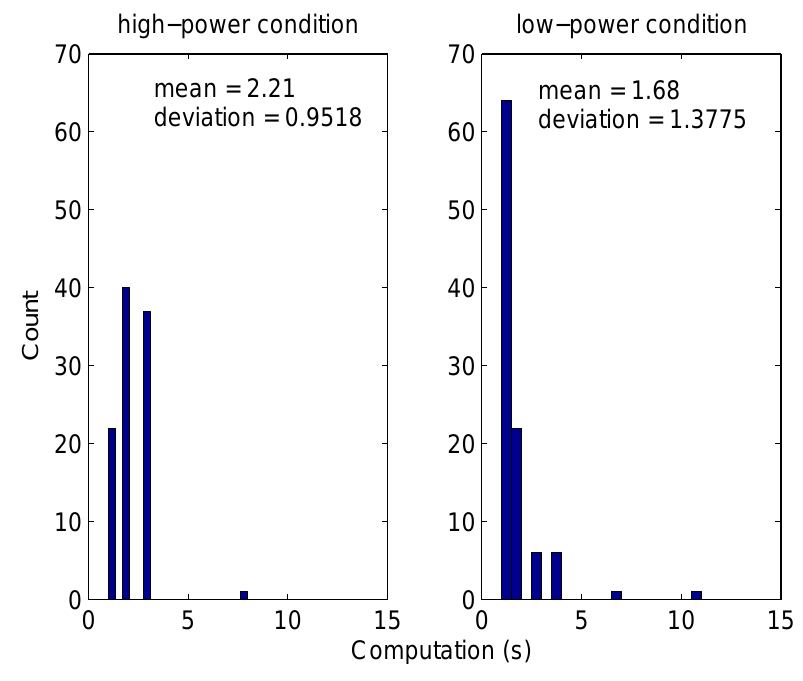
Figure 22. Histogram of the computation time under the response-time-oriented policy for ( left ) high and ( right ) low power storage